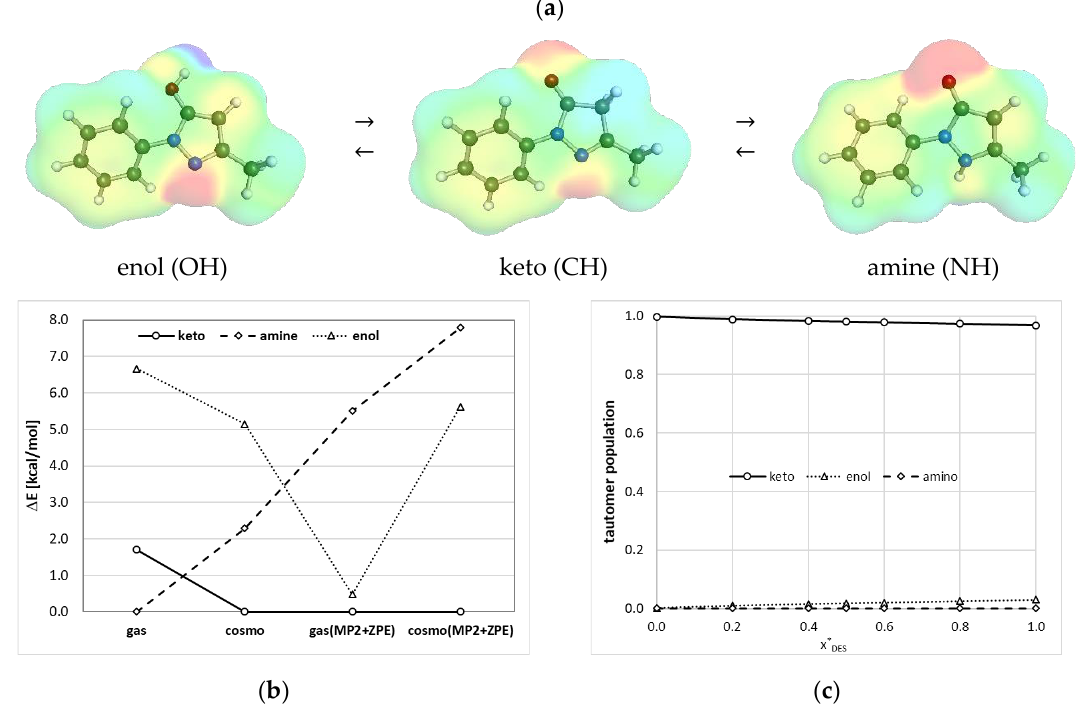
Figure 5. Tautomeric properties edaravone ( a ) tautomerisation scheme with charge densities distributions; ( b ) relative values of energy estimated in the gas and bulk phase using DFT approach and corrected for electron correlation and ZPE; ( c ) exemplary plot of tautomers’ populations in ETA (ChCl:EG = 1:2) at T = 298.15 K as a function of DES mole fraction (x *DES ).